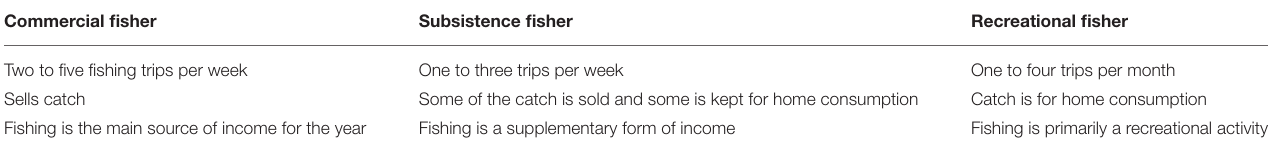
TABLE 1 | Classification and characteristics of fishers on Moorea.